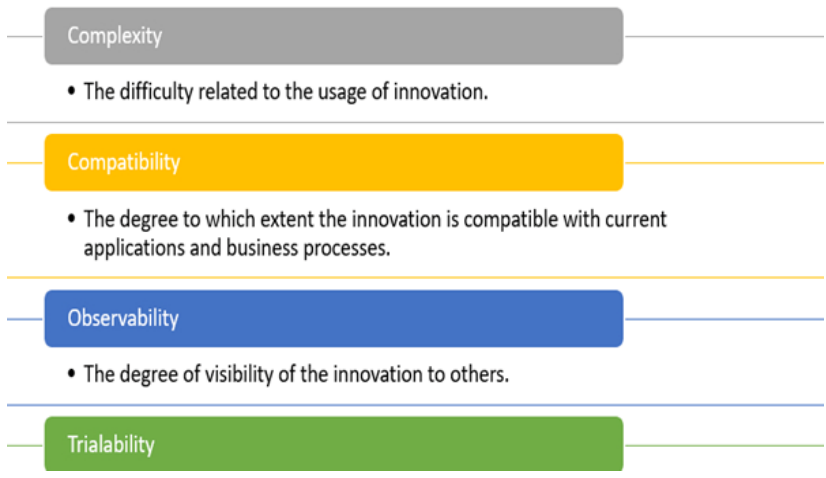
Figure 5. Diffusion of innovation (DOI) characteristics.